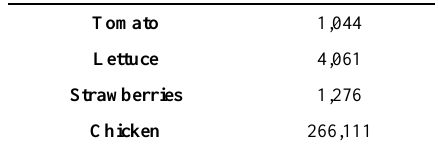
Table 3. September GHG emissions in kg per product.